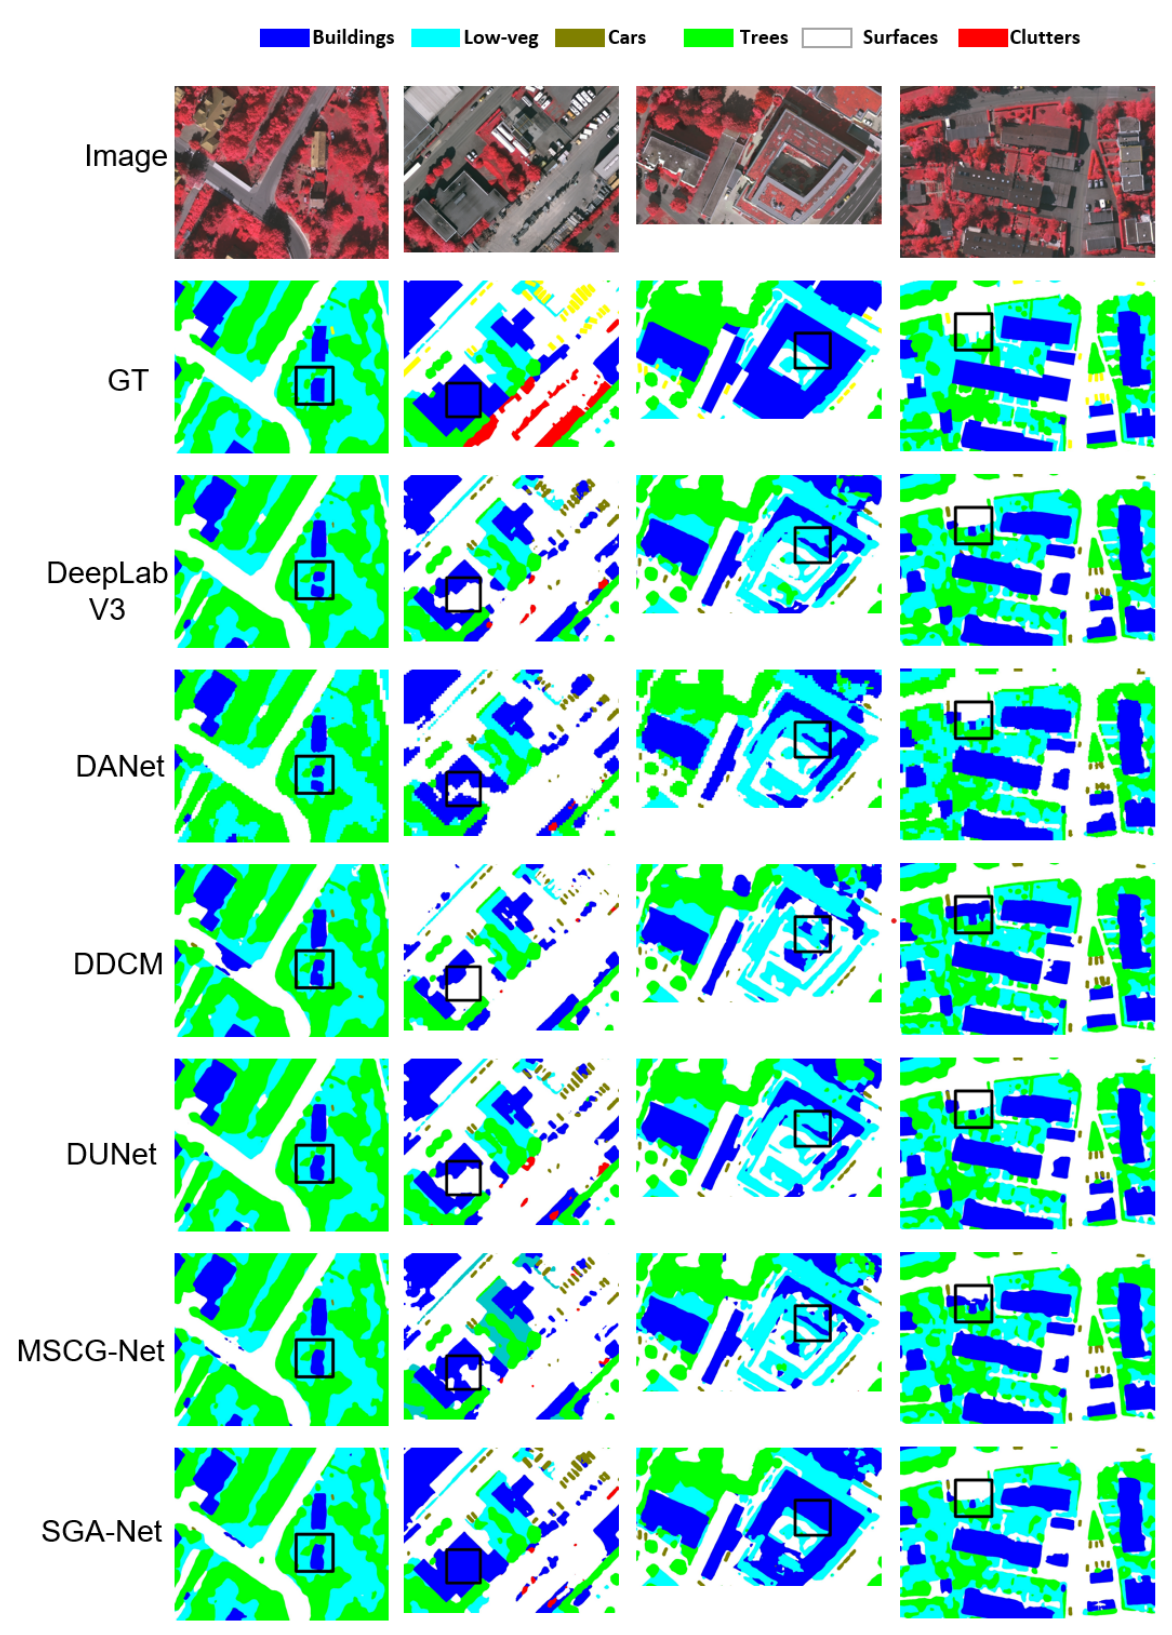
Figure 6. Visualization of prediction detail in the Vaihingen